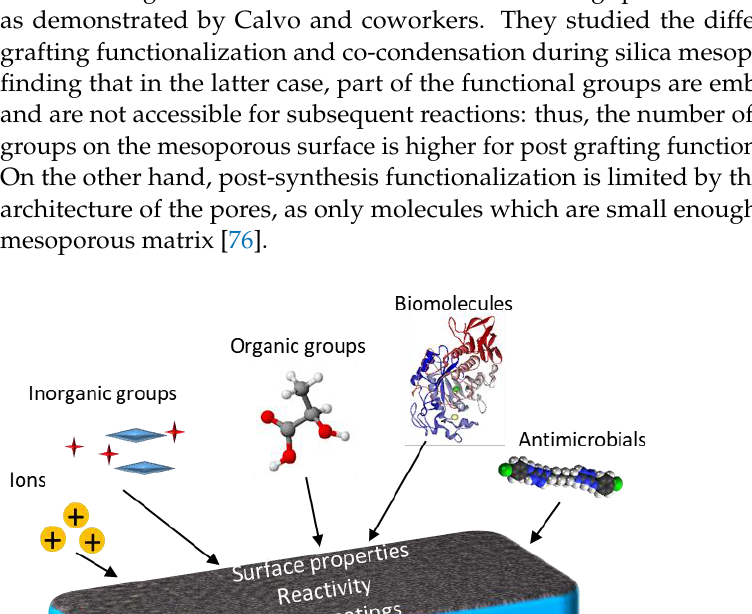
Figure 1. Schematic illustration of the various functionalization groups of mesoporous thin films. Functionalization can be obtained in different ways [52,65,72,73], the most common methods are co-condensation and post-grafting. In co-condensation the functionalizing group is added to the sol – gel solution and thus is distributed throughout the whole ma- terial bulk.